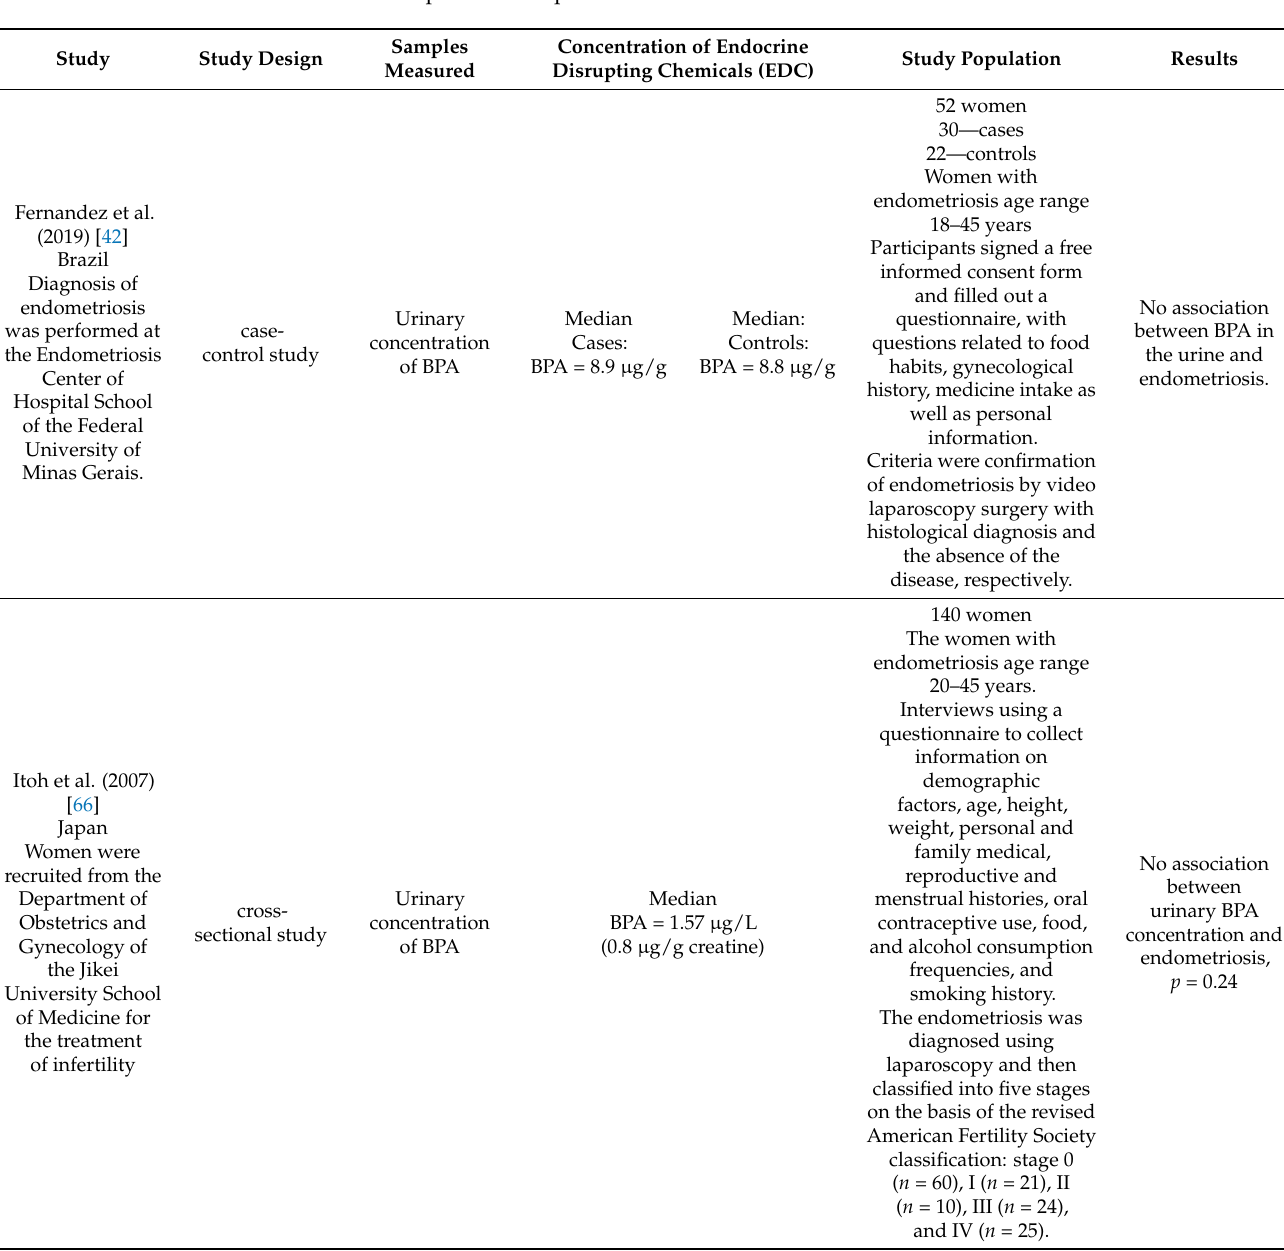
Table 2. Exposure to Bisphenol-A and